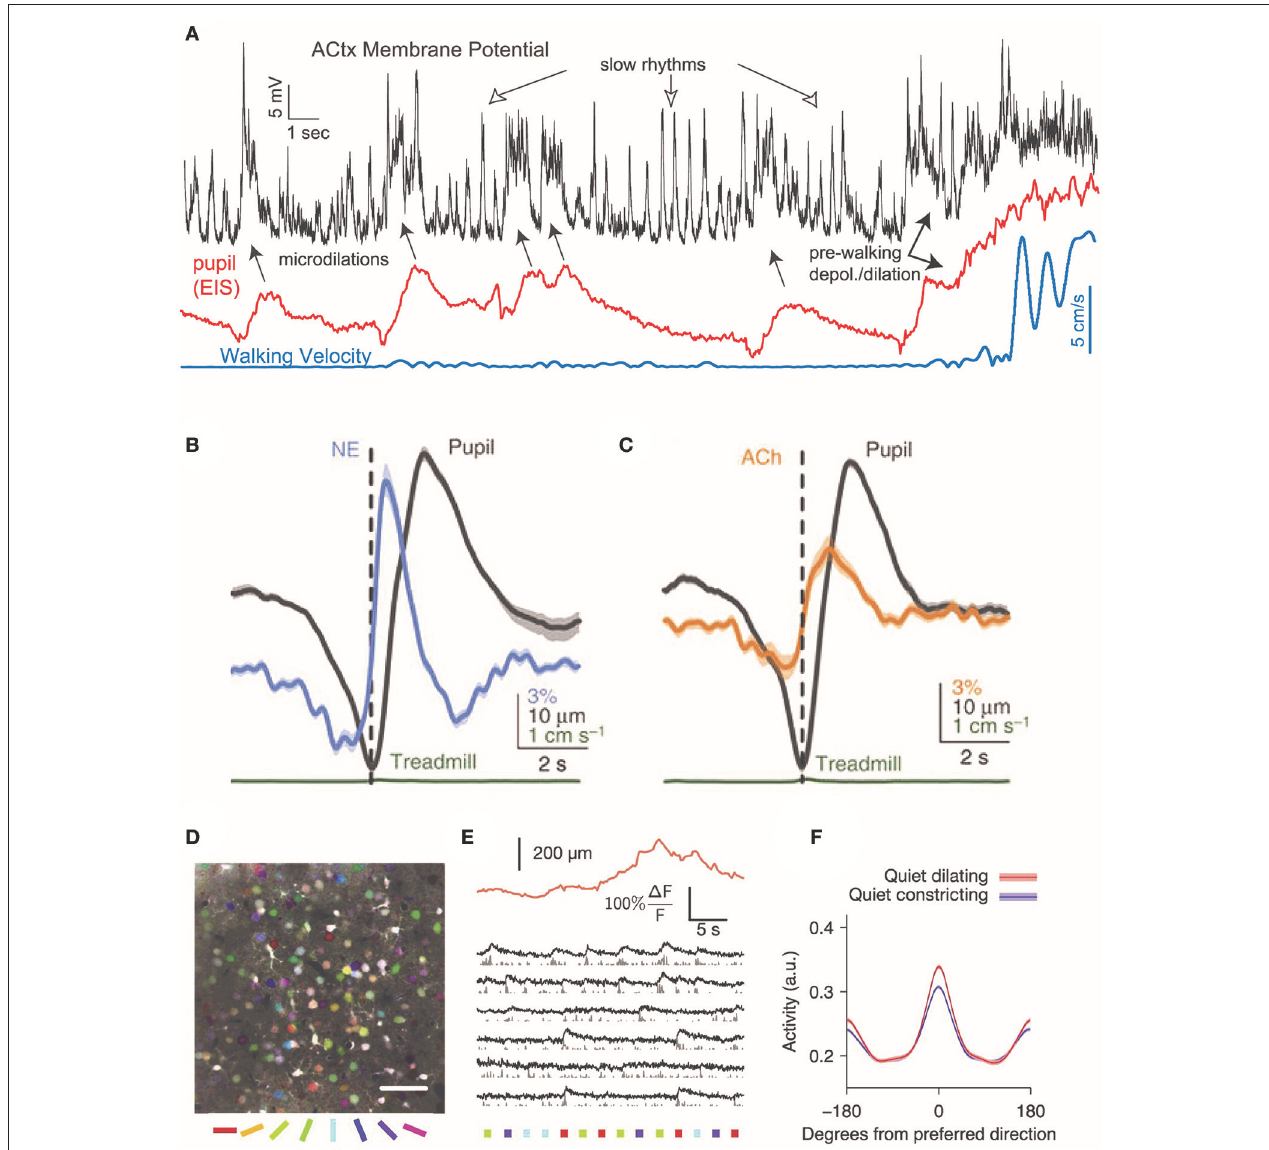
FIGURE 2 | Cortical responses during pupil dilations. Changes in cortical pyramidal cell membrane potential coincide with changes in neuromodulatory signaling in the mouse auditory cortex. (A) During rapid, brief dilations (microdilations) in the absence of locomotion (blue), the cortical pyramidal cell membrane is depolarized 5–20mV (black). Periods of locomotion are accompanied by membrane depolarization and large pupil diameters (red: eye-indexed state (EIS) is a measure of infrared reflectance used as a proxy for pupil diameter). Reprinted with permission from McGinley et al. (2015). (B,C) In the absence of locomotion, the activity of